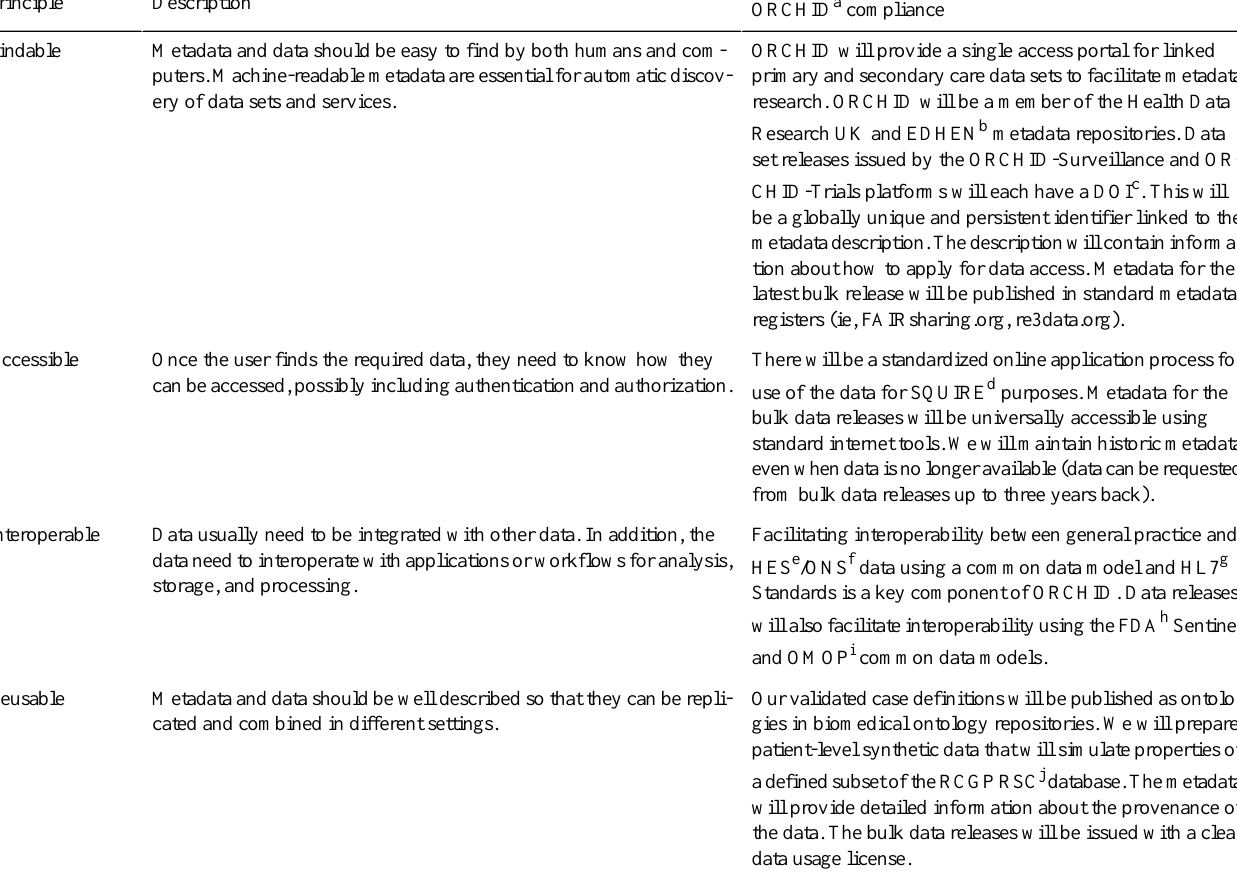
Table 1. FAIR principles (adapted from [5]) and ORCHID compliance.